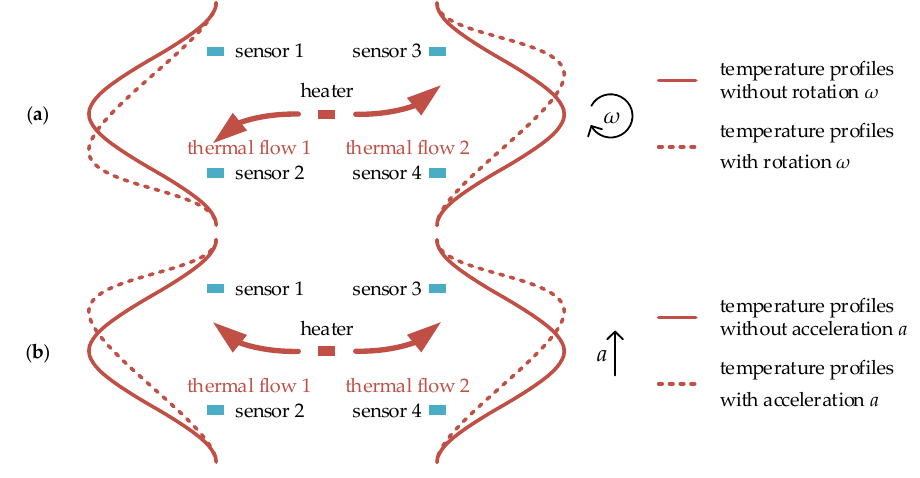
Figure 3. The schematic of thermal gas gyroscope, ( a ) temperature profiles deflected by Coriolis acceleration and ( b ) temperature profiles deflected by linear acceleration. acceleration and ( b ) temperature profiles deflected by linear